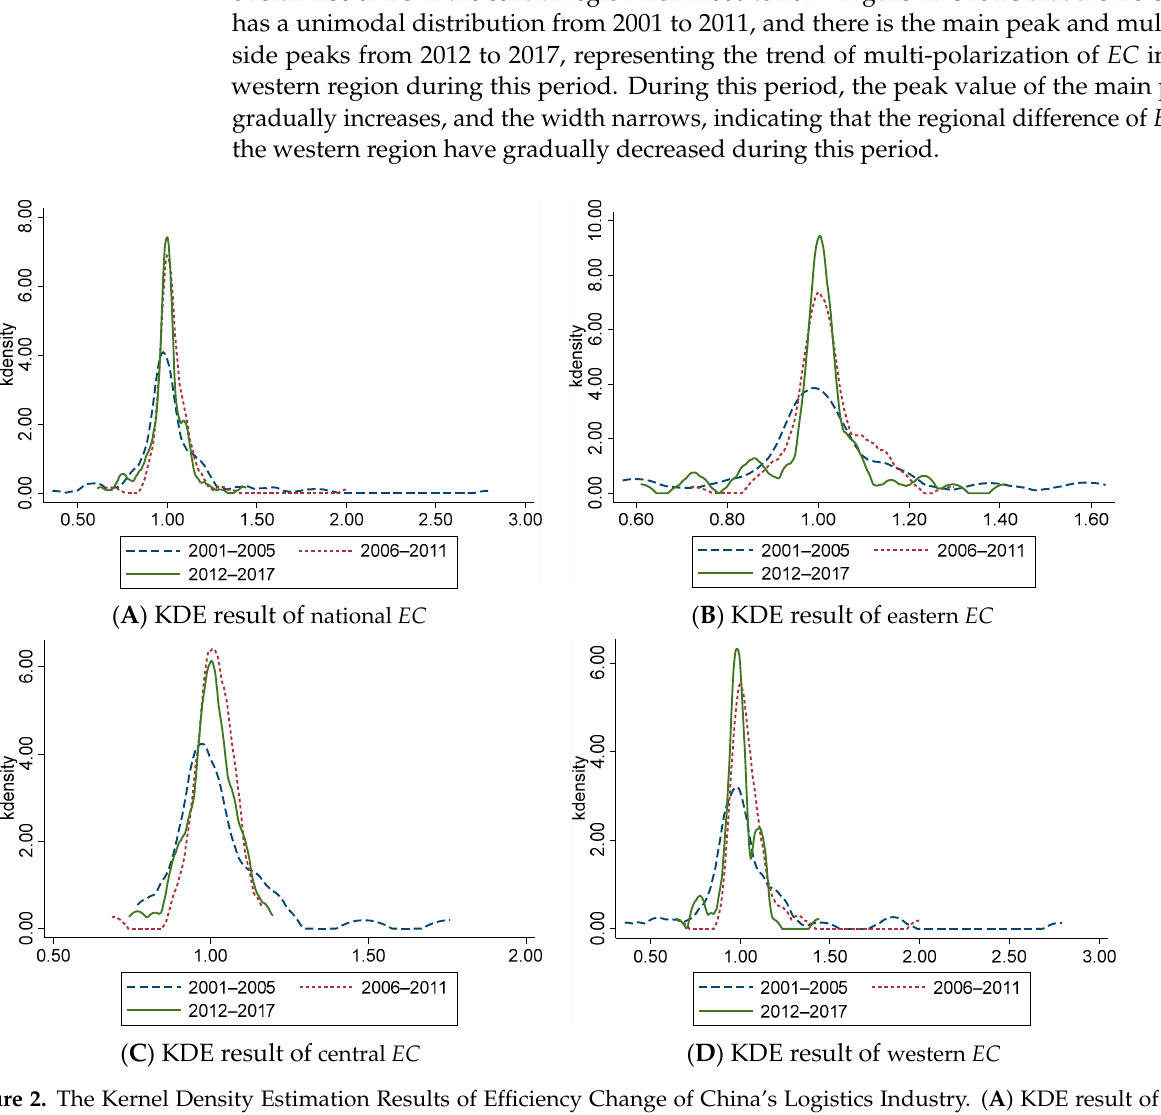
Figure 2. The Kernel Density Estimation Results of Efficiency Change of China’s Logistics Industry. ( A ) KDE result of national EC ( B ) KDE result of eastern EC ( C ) KDE result of central EC ( D ) KDE result of western EC.